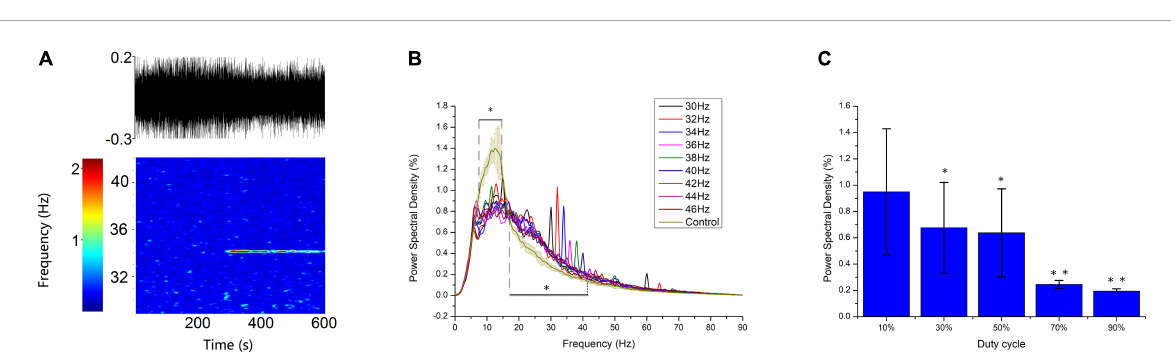
FIGURE9 Experimental verification of the simulation entrainment. (A) Spectrogram analysis of 34-Hz flicker entrainment. Top: raw LFP of 10 min; Bottom: heatmap of the raw LFP. The flicker was turned on at 300 s. (B) A 5-min frequency power spectrum of flicker stimulation with different frequencies on a typic electrode. Error bars indicate s.e.m.; ∗ indicate two-sample t -test between the oscillatory power with flicker stimulation and without flicker stimulation for all frequencies within the horizontal line, unequal variance statistical significance, n = 9 , p < 0 . 01. (C) Power spectra density of flicker stimulation with different duty cycles at 40 Hz. Error bars indicate s.e.m.; ∗ indicate two-sample t -test between 10% duty cycle and 30% or 50% duty cycle; ∗∗ indicate two-sample t -test between 50% duty cycle and 70 or 90% duty cycle, unequal variance statistical significance, n = 16, p <